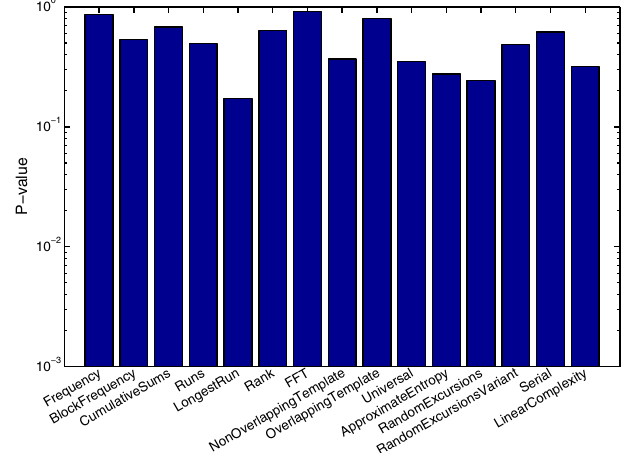
FIG. 9. The P value of the statistical tests. The x axis lists the names of statistical tests in the NIST test suite. The final data size is 91 Mbit, which is extracted from 115-Mbit raw data. To pass each test, the P value should be at least 0.01, and the proportion of sequences that satisfy P > 0 . 01 should be at least 96%. It can be seen in the figure that the P values of all tests are greater than